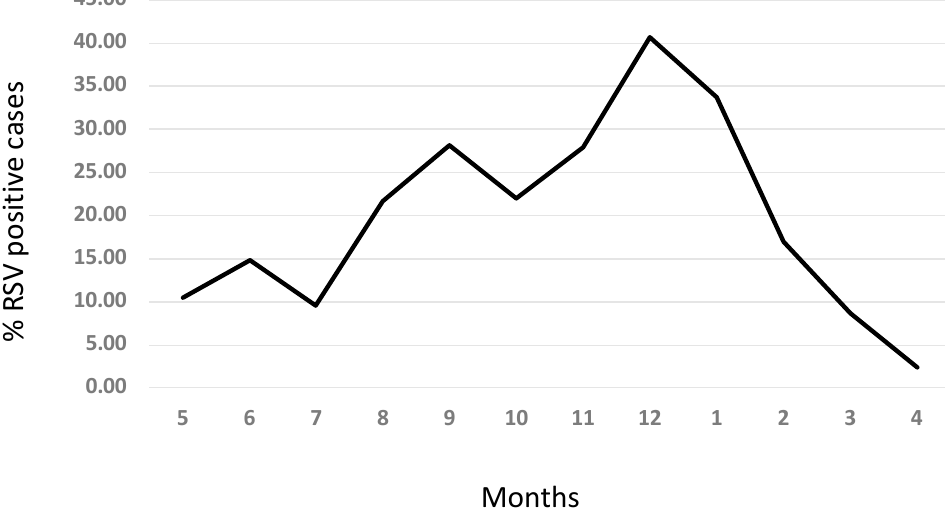
Figure 1. Seasonal pattern of RSV infection.